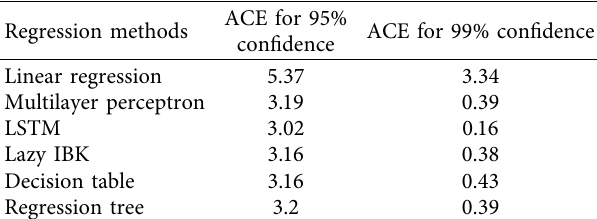
Table 4: Performances of different methods on wind power in- terval